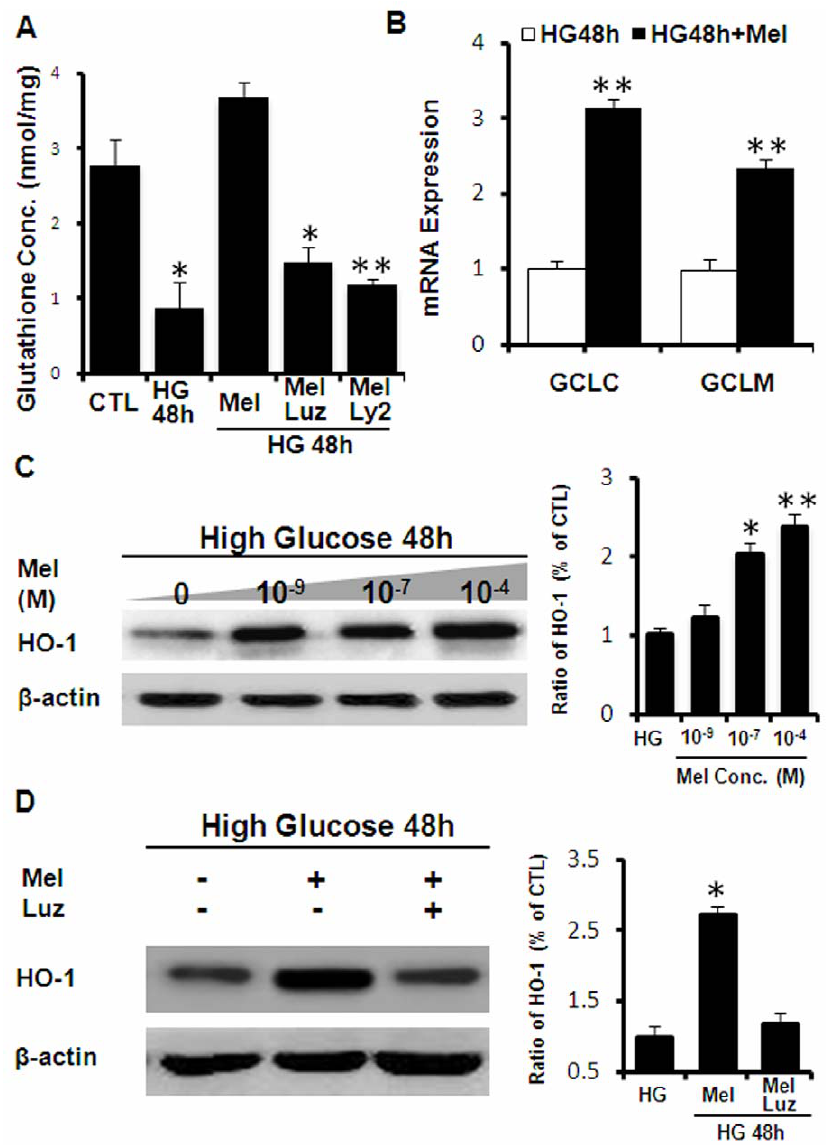
Figure 3. Protection against high glucose-induced oxidative stress by melatonin. (A) Measurement of cellular glutathione contents in Mu¨ller cells exposed to high glucose. Cells were treated with 30 mM glucose (HG) alone or in together with 0.1 mM melatonin (Mel), 50 m M luzindole (Luz) or 50 m M LY294002 (Ly2). Glutathione was measured by the DTNB method. (B) Upregulation of GCLc and GCLm measured by real-time RT-PCR and normalized to b -actin mRNA. (C) Western blot analyses of HO-1 expression after co-treatment with high glucose and indicated concentrations of melatonin (Mel). (D) Effects of luzindole on melatonin-induced upregulation of HO-1. Data presented are average from 3 to 5 experiments (*P , 0.05; **P ,